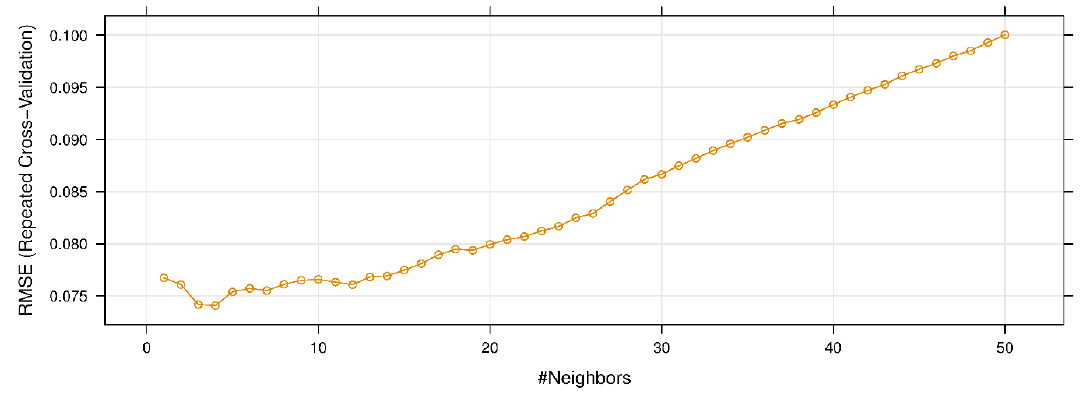
Figure 10. Performance of the k-nearest neighbors (KNN) model with various k.